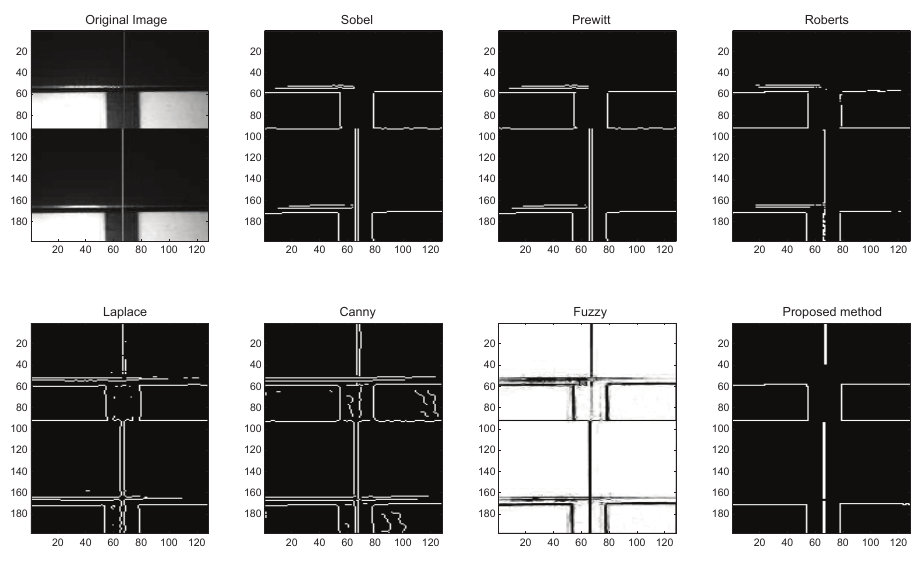
Figure 9. Comparison between conventional and the proposed methods for edge detection in noise-free gap images.